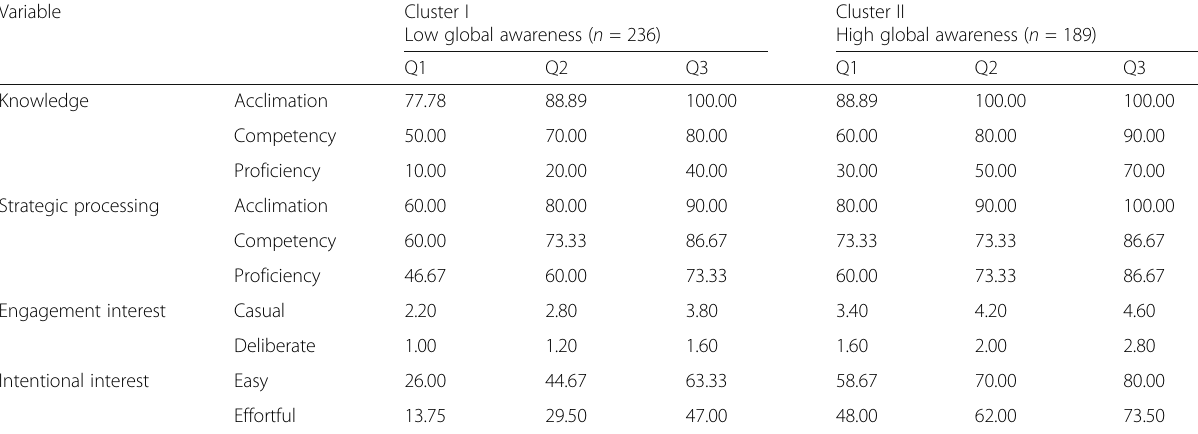
Table 7 First quartile (Q1), median (Q2), and third quartile (Q3) for knowledge, strategic processing, and interest for the low and high global awareness clusters